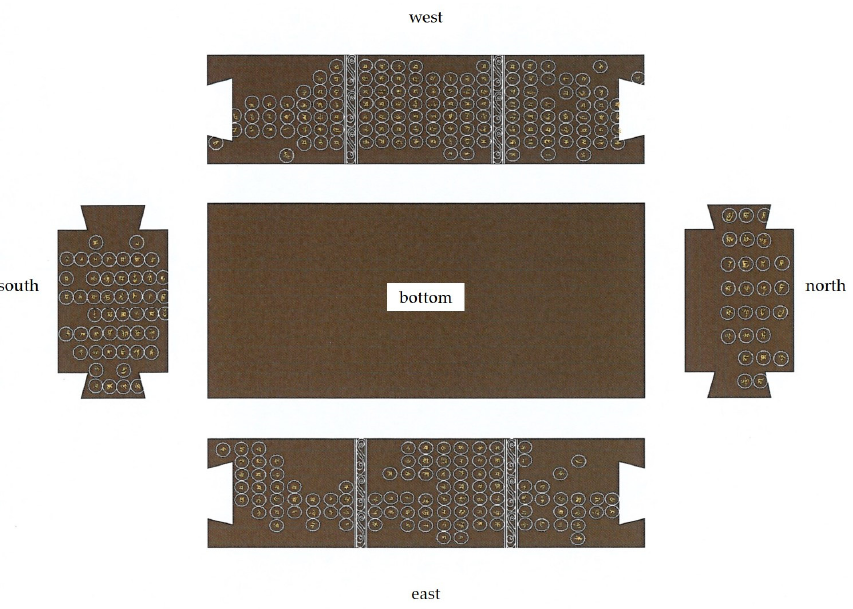
Figure 13. Diagram of the inner coffin from the Nongso Tomb. After (Kungnip Naju munhwajae yŏn’guso 2016, p. 131, Diagram 37) with y ŏ n’guso 2016, p. 131, Diagram 37) with modifications.